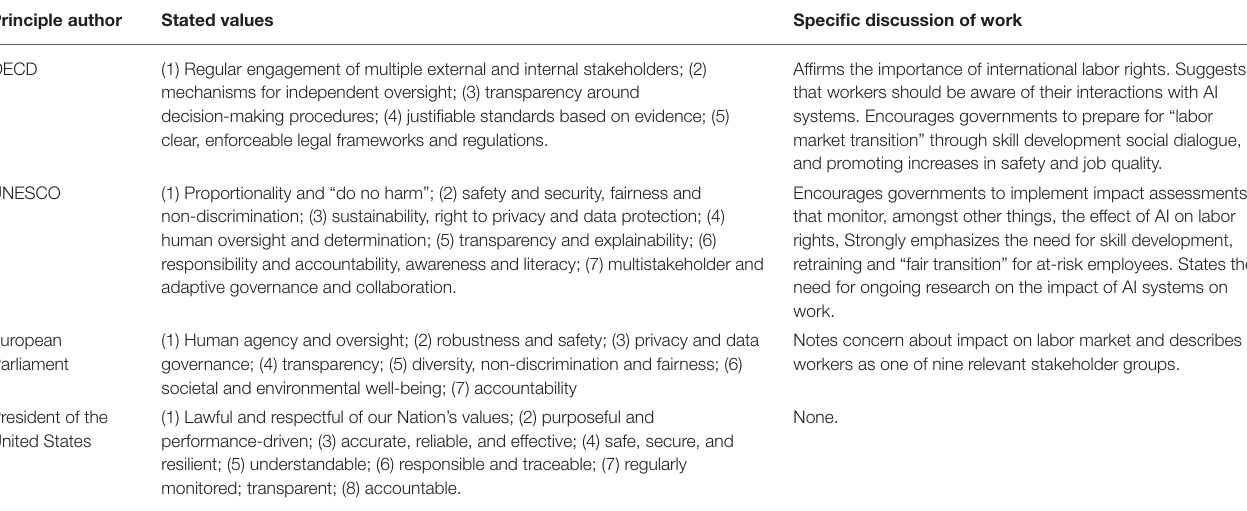
TABLE 1 | Summary of four illustrative AI